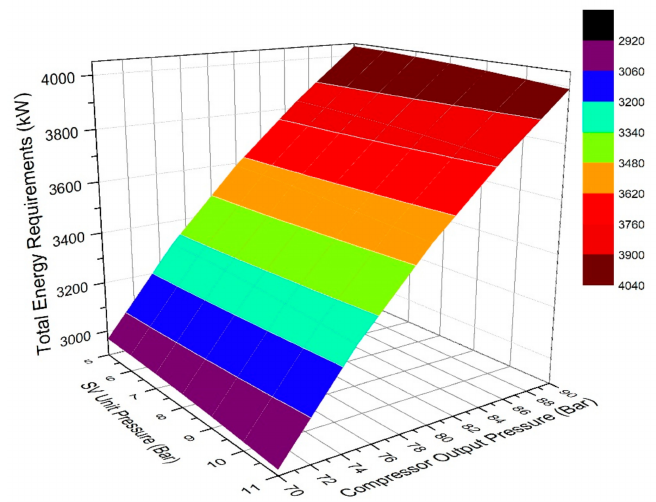
Figure 8. Combined impact of compressor discharge pressure and throttling pressure of the SV unit on the total energy requirements of the SV process (case A).